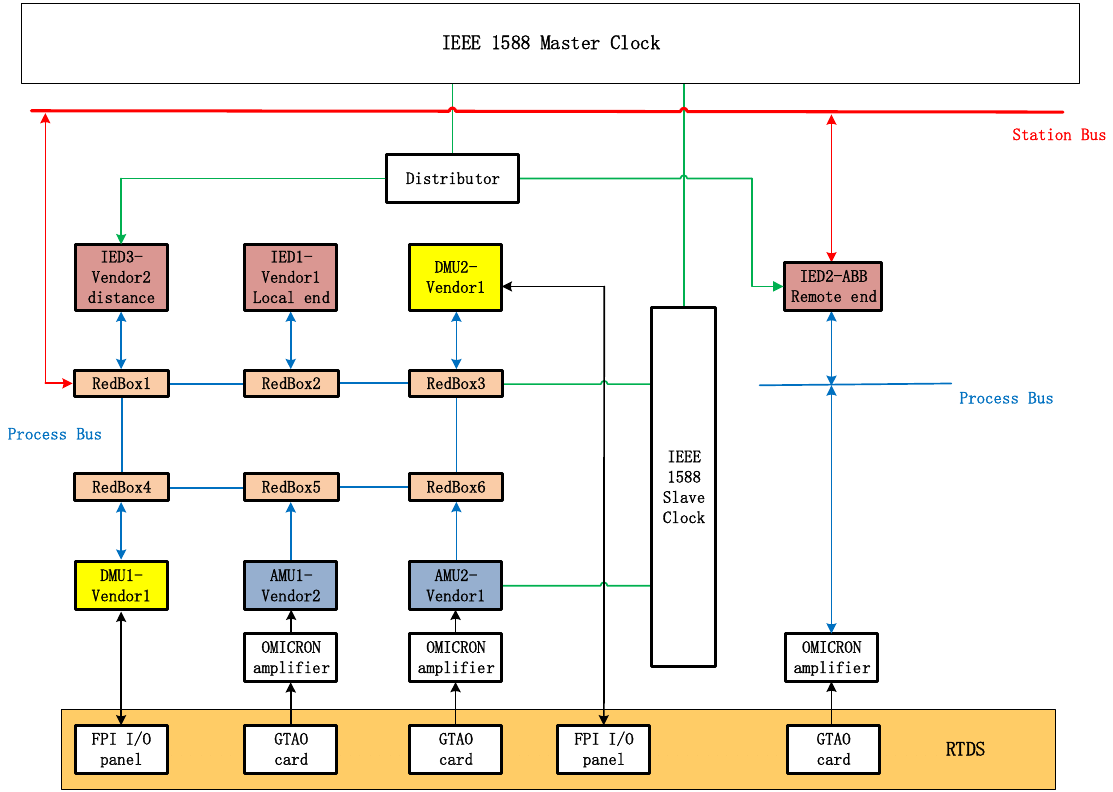
Figure 7. Future intelligent transmission network substation laboratory implementation of HSR- only architecture.